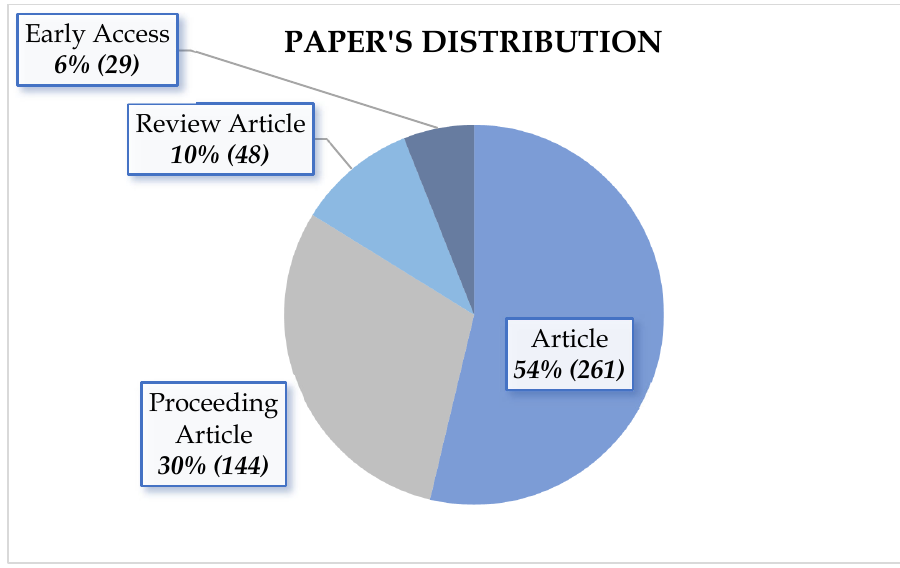
Figure 3. Percentage of papers’ distribution in this research.